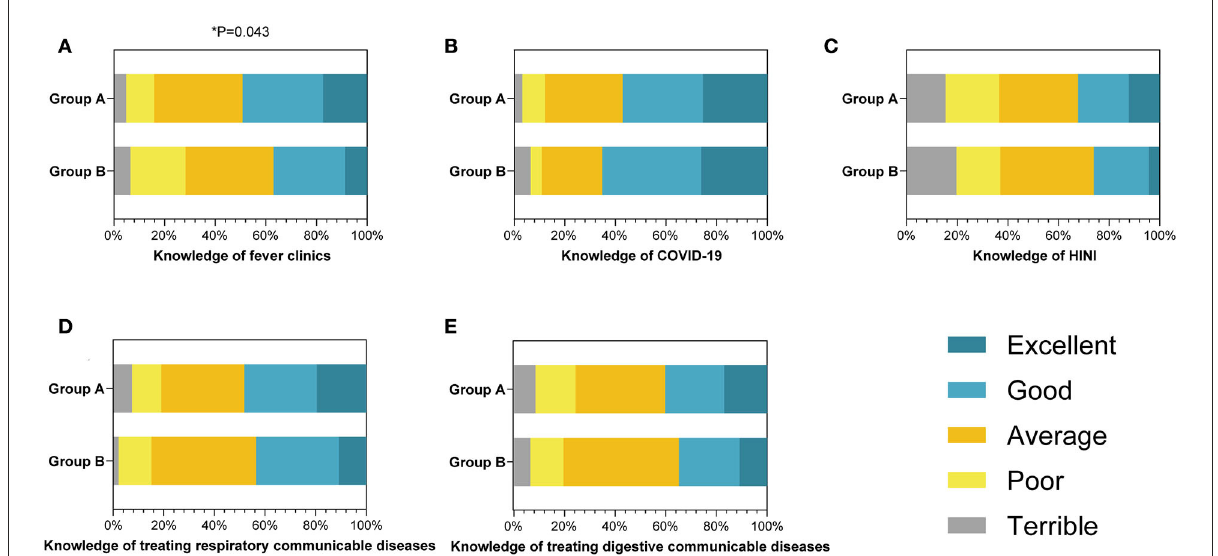
FIGURE3 The percentage stacking histograms of the comparison in the knowledge of communicable diseases associated with public health emergency (PHE) between clinical and preventive medicine students with a 5-point Likert scale. (A) The knowledge of fever clinics between clinical and preventive medicine students. (B) The knowledge of COVID-19 between clinical and preventive medicine students. (C) The knowledge of H1N1 between clinical and preventive medicine students. (D) The knowledge of treating respiratory communicable diseases between clinical and preventive medicine students. (E) The knowledge of treating digestive communicable diseases between clinical and preventive medicine students. The nonparametric test was applied for the comparison (The number of group A is n1 = 189; the number of group B is n2 =